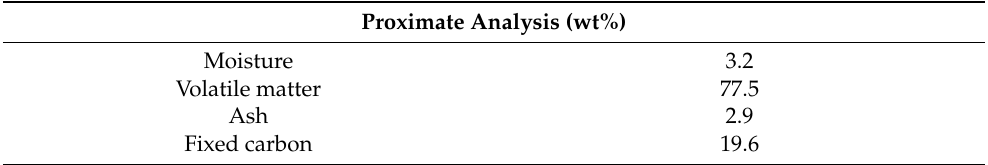
Table 2. Proximate analysis of coconut shell.